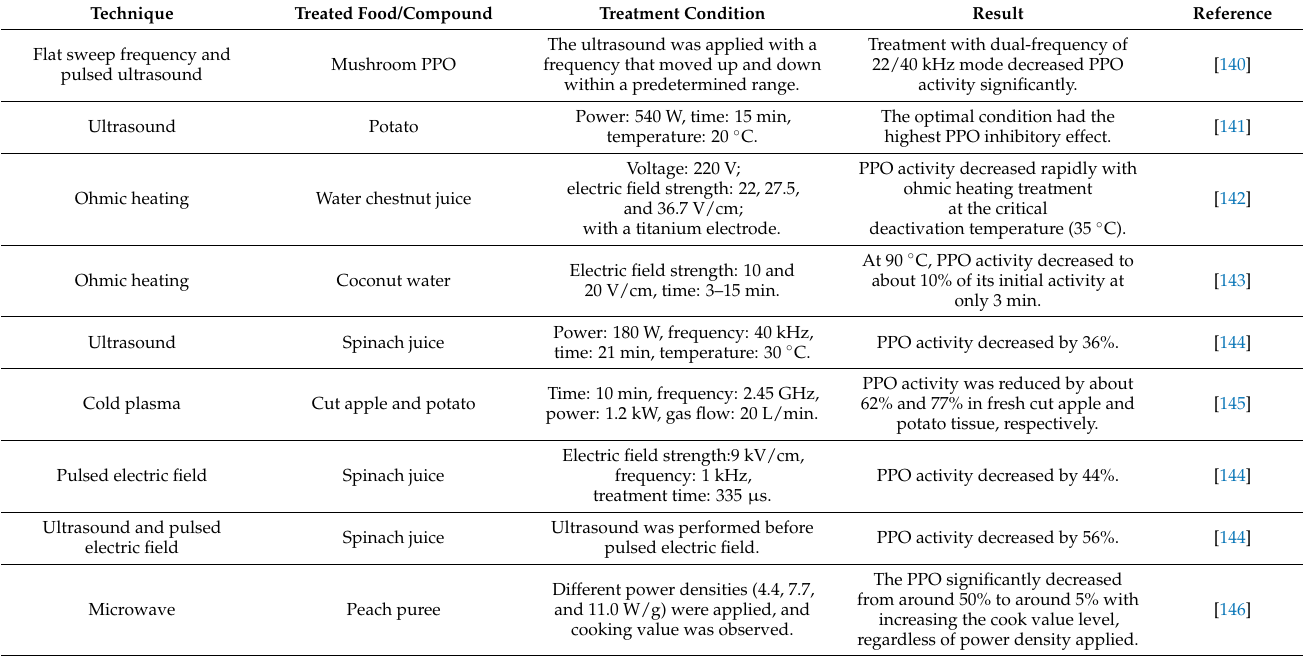
Table 6. Effect of different novel technologies on